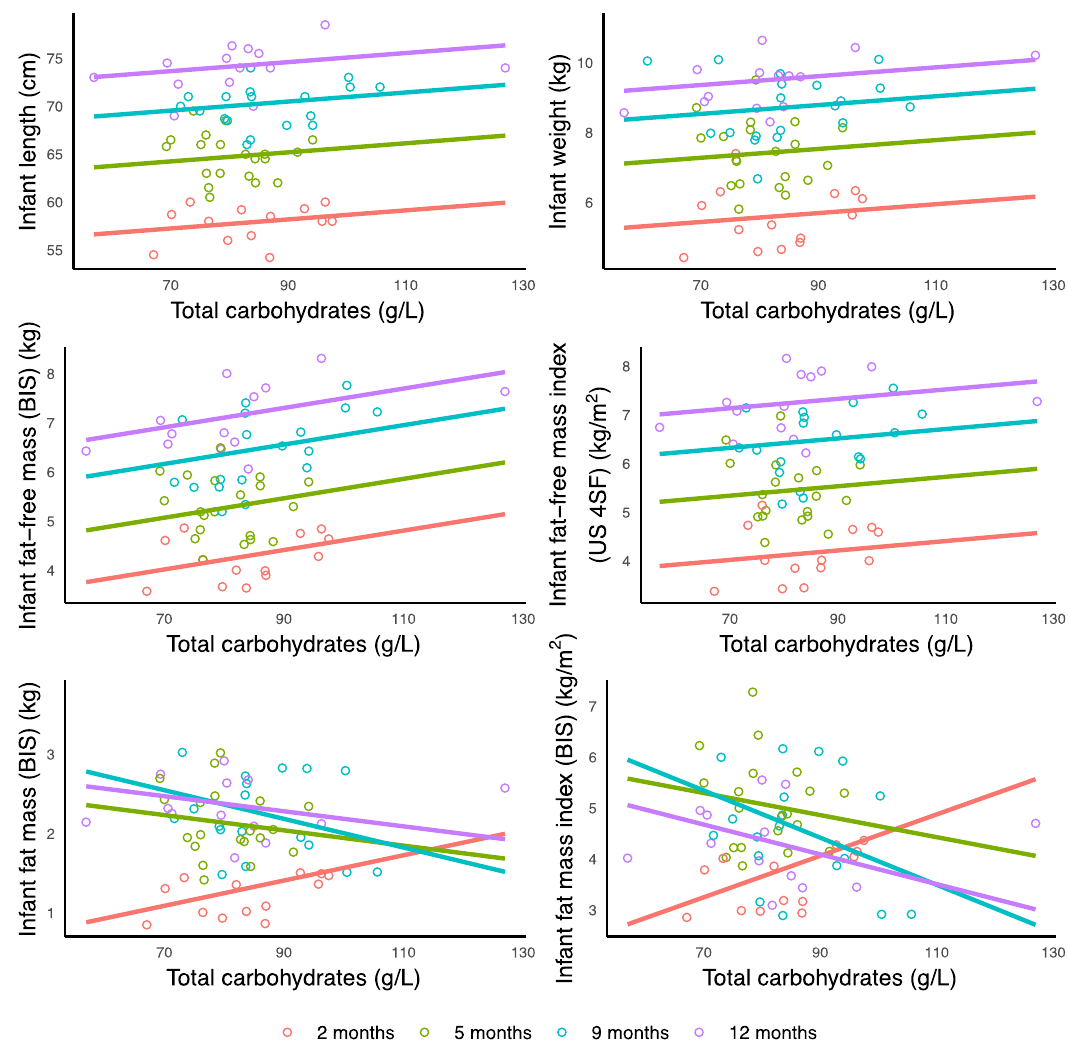
Figure 1. Significant associations between concentration of total carbohydrates and infant anthropometric and body composition measurements. Lines represent linear regression and grouped by the month of lactation. BIS: bioelectrical impedance spectroscopy; US 4SF: ultrasound 4-skinfolds. Higher HMO concentration was associated with increased FFM (BIS: p < 0.001) and FFMI (BIS: p = 0.008). Higher HMO concentration was associated with an increase in adiposity measured with BIS (FMI: p = 0.003; %FM: p = 0.005; FM / FFM: p = 0.006) at 2 months and decrease at 5, 9 and 12